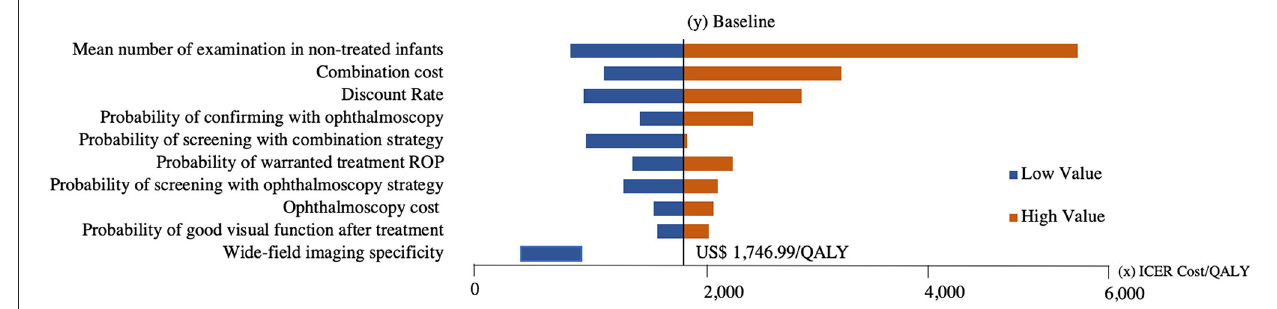
FIGURE 2 | Tornado diagram of the 10 parameters that most impacted the incremental cost–utility ratio (ICUR). X axis represents the impact on the ICUR in US dollars (USD) cost per quality-adjusted life-years (QALY) of each parameter variation, and Y axis represents baseline parameters with an ICUR of USD 1,746,99/QALY. Orange and blue bands show each parameter high and low values, respectively.